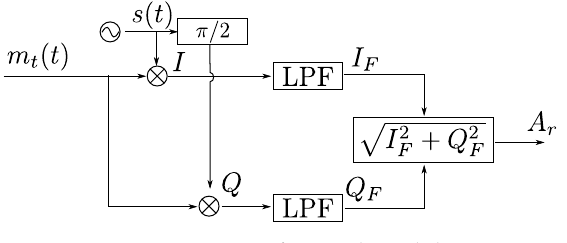
Figure 5. Diagram of an IQ